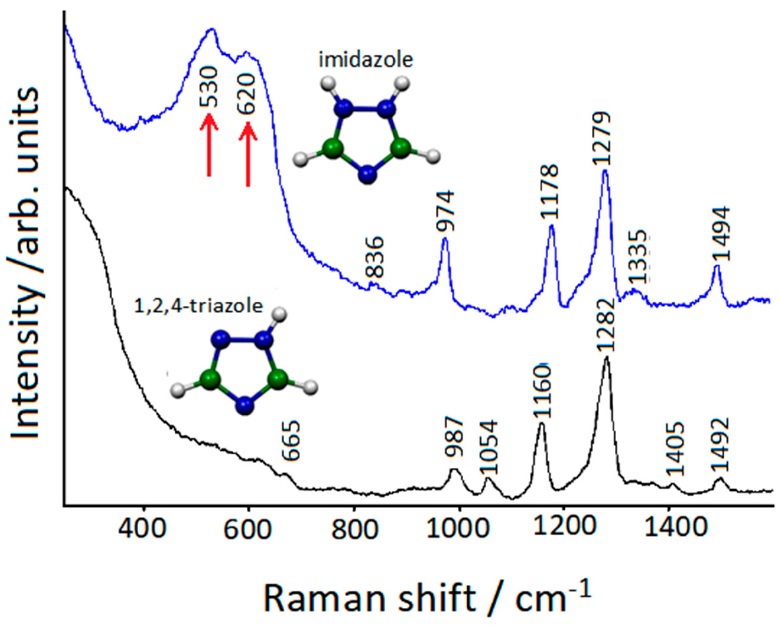
Figure 9. SERS spectra of 1,2,4-triazole and imidazole absorbed on etched copper surfaces. 2.5. Push-Pull Molecule Adsorbed on Silver Colloidal Nanoparticles